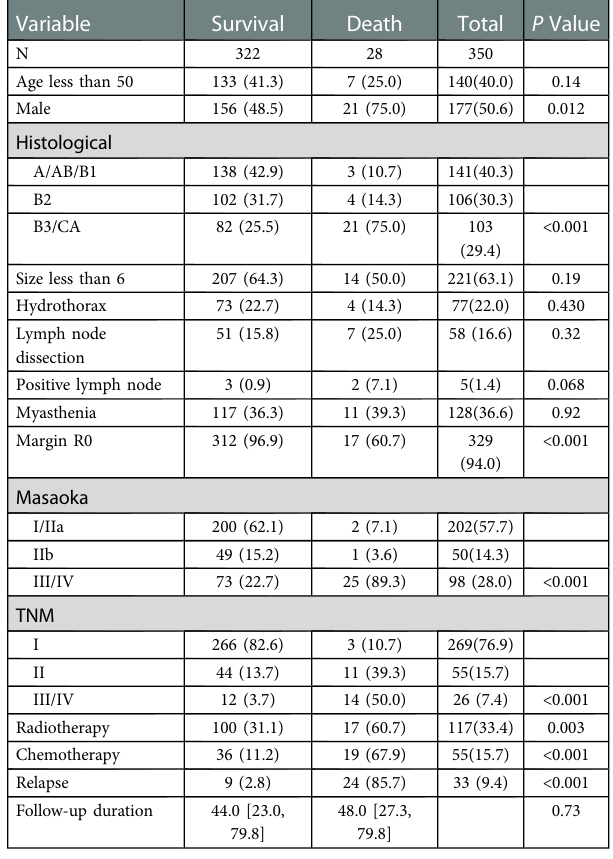
TABLE 2 Baseline characteristics of participants by Status.